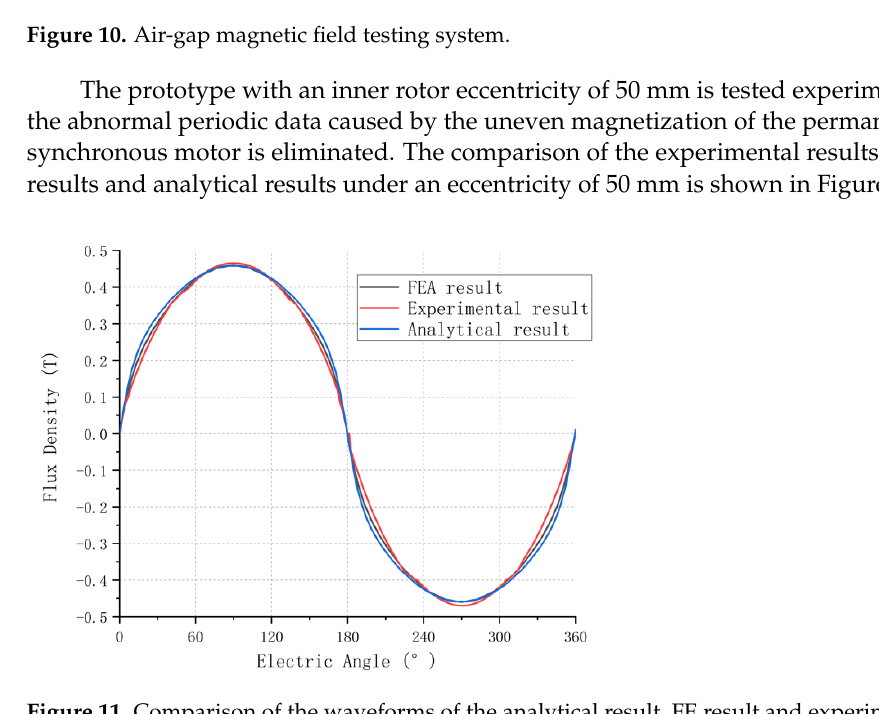
Figure 12. Comparison of the harmonic components of the analytical result, FE result and experi- mental result. According to the results of the air-gap flux density waveform and the harmonic com- ponent of the magnetic field waveform, the experimental results, simulation results and analysis results have a high consistency. When the eccentricity value is 50 mm, according to Formula (1), THD is 7.41%, which is −0 .68% different from the simulation result. The THD difference is very small, which verifies the correctness of the finite element simula- tion results. To summarize, the experimental results show that before the optimal design of the inner rotor, the THD is 34.11%. When the eccentricity of the inner rotor is 50 mm, the THD decreases from 34.11% to 7.41%, which proves that the hollow-cup motor model based on the eccentricity of the inner rotor can effectively improve the shape of the air-gap magnetic field waveform and make it present the sinusoidal waveform more closely. At the same time, compared with the design of the PMs ’ eccentric device, it is more convenient for PMs ’ magnetization and manufacturing, and has a certain engineering application value. 5. Conclusions In this paper, the equivalent surface current method is used to establish the mathe- matical model of the air-gap magnetic field of a hollow-cup permanent magnet motor, and the analytical formula of the air-gap magnetic field after the inner rotor is eccentric is obtained. Motor models with different inner rotor eccentricity values are established by finite element software, and the air-gap magnetic field waveforms are analyzed. Then,